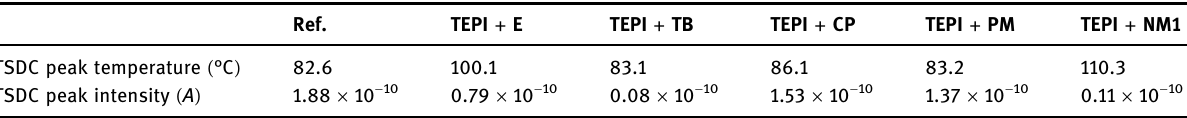
Table 3: TSDC main peak temperature and peak intensity